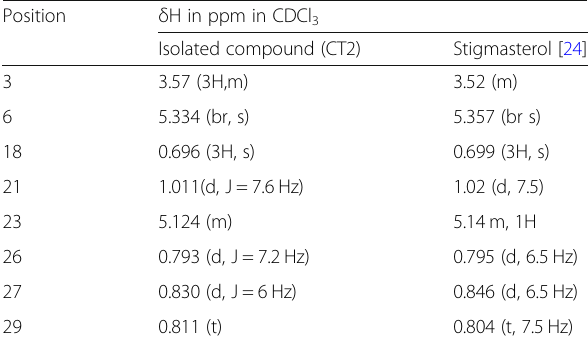
On the basis of NMR data, the isolated compound was confirmed as stigmasterol and structure of stigmasterol is shown in (Fig.